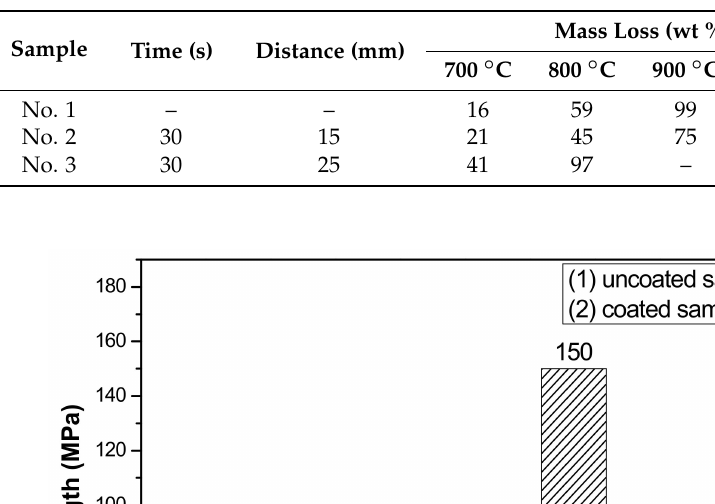
Figure 5. The TG ( a ) and DTG ( b ) curves of uncoated (1) and coated sample, deposition time 30 s and spraying distance 15 mm (2) and deposition time 30 s and spraying distance 25 mm (3). Table 1. Mass loss at different temperature stages in air (according to TG data).